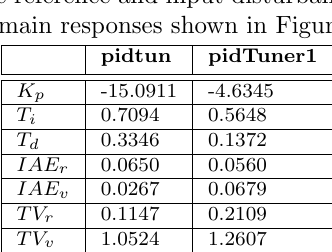
Table 1: Example 4.1. The table shows the PID con- troller ( m = 2) parameters, K p , T i , and, T d . It shows performance and input usage indices, IAE r , IAE v , TV r , and, TV v , corresponding to the reference and input disturbance step time domain responses shown in Figure 3.